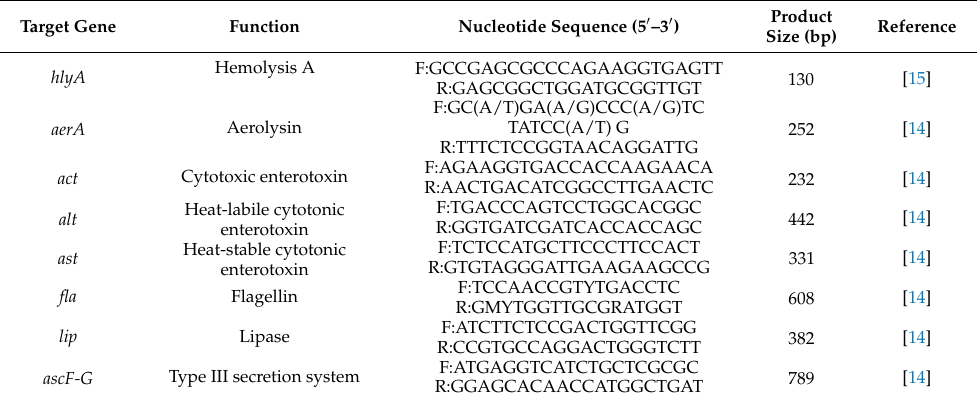
Table 1. Primer sequences of Aeromonas virulence